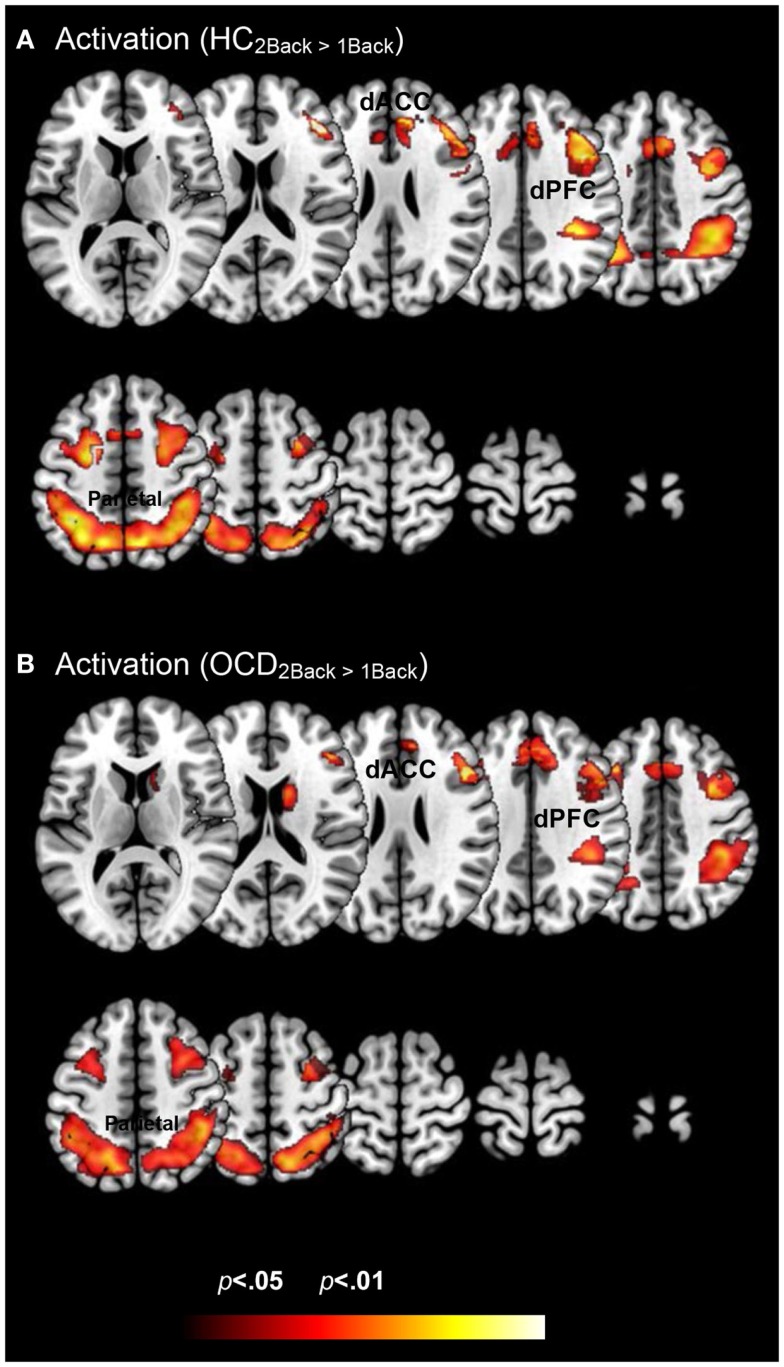
Within group changes in activation profiles as a function of load are depicted on identical ascending mosaics of axial views. The significant clusters (p < 0.05, cluster level) show significant increases in activation with increases in working memory related load. As seen, these increases are evident within both (A) healthy control and (B) OCD groups. These activation profiles establish within group effects of memory load across previously implicated load sensitive working memory related regions. These include dorsolateral prefrontal cortex (dPFC), the dorsal anterior cingulate (dACC), and the parietal cortex.